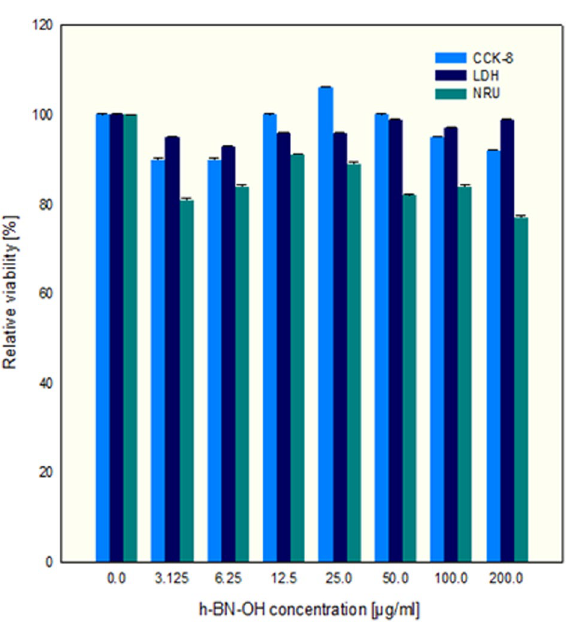
Figure 9. Relative viability of L929 cells after 24-hour incubation with h-BN-OH-n. Values shown are means ±